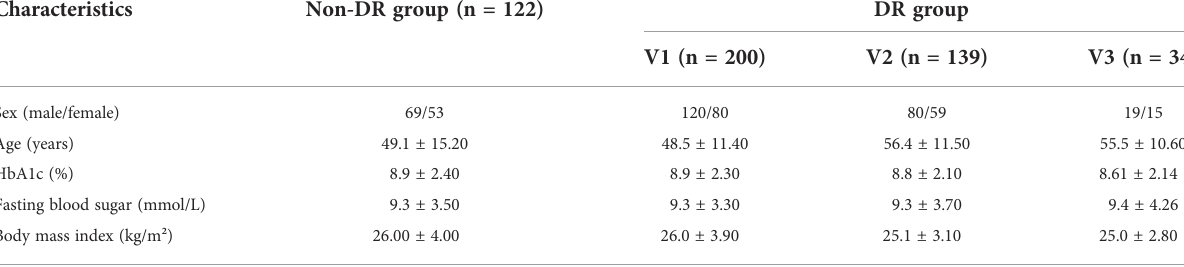
TABLE 1 The detailed characteristics of patients in different